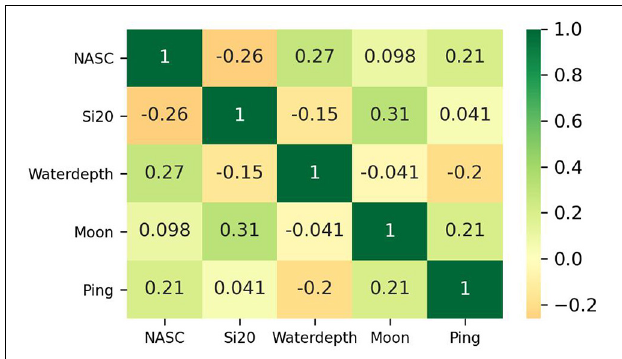
FIGURE 5 | Pearson’s correlation matrix between the nautical area scattering coefficient (NASC) and the first-order